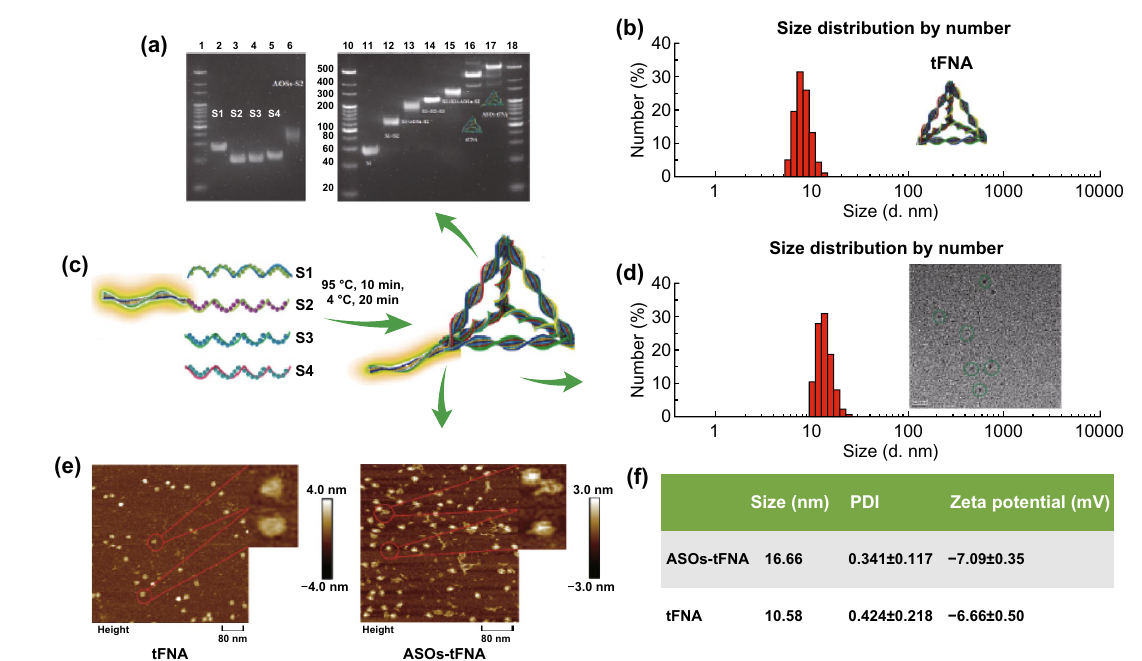
Fig. 1 Characterization of tFNAs and ASOs-tFNAs. a Relative size of ssDNA (S1 to S4), partially assembled delivery systems, tFNA, and ASOs-tFNA based on non-denaturing polyacrylamide gel electrophoresis. Lanes 2 and 11: S1; lane 3: S2; lane 4: S3; lane 5: S4; lane 6: ASOs- S2; lane 12: S1 + S2; lane 13: S1 + ASOs-S2; lane 14: S1 + S2 + S3; lane 15: S1 + S3 + ASOs-S2; lane 16: tFNA; lane 17: ASOs-tFNA; lanes 1, 10, and 18: MW marker, b dynamic light scattering measurement of tFNA size distribution, c schematic representation of the synthesis of the tetrahedral FNA delivery system (ASOs-tFNA), d dynamic light scattering measurement of ASOs-tFNA size distribution and TEM image of ASOs-tFNAs (green dotted line), e AFM images of tFNA (red dotted line) and ASOs-tFNA (red dotted line), f summary of different parameters describing ASOs-tFNA and tFNA. (Color figure